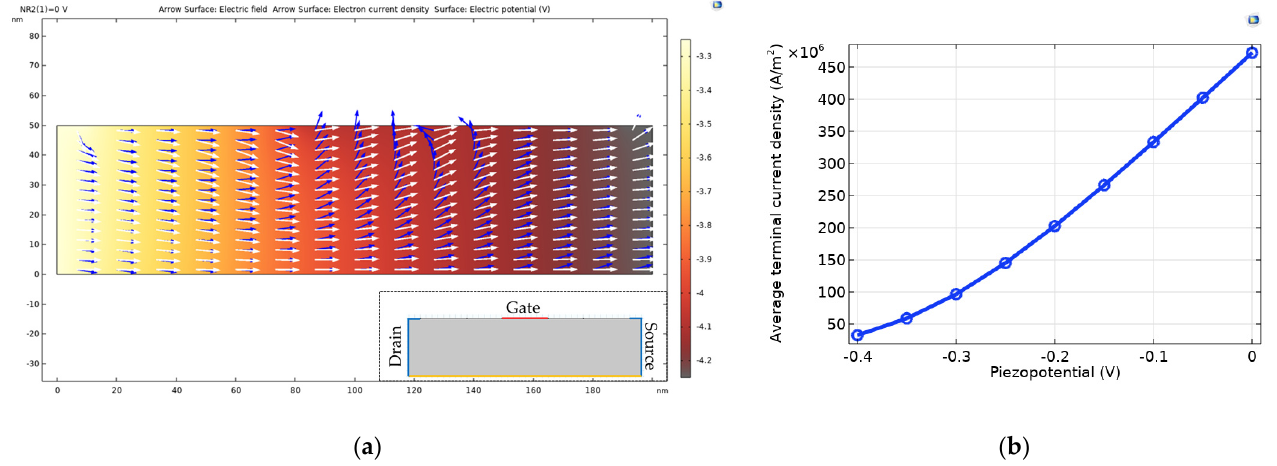
Figure 11. COMSOL simulation for validation of mobility change; ( a ) Lateral current density change by vertical E-field in the ZnO. Drain-source was defined at both ends like an inset. To simulate the polarization at the ZnO channel interface, the gate electrode was defined on the top and it means the place where the nanorod was locally grown; ( b ) Results of current density flowing through the ZnO channel when a gate voltage (piezopotential) is applied. As the polarization increased, the current decreased.